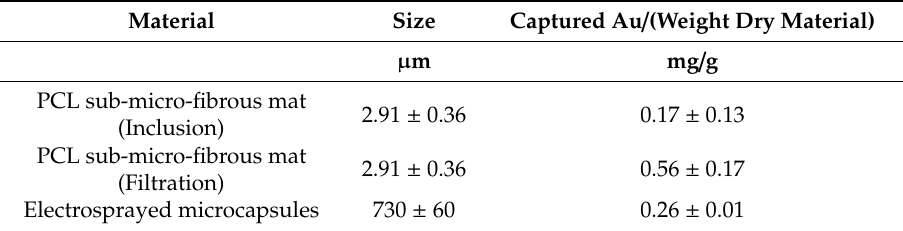
Table 1. Comparison between the gold sorption e ffi ciency of the PCL bio-composite mat and the alginate microcapsules with Lysinibacillus sphaericus CBAM5, after 2 h of the